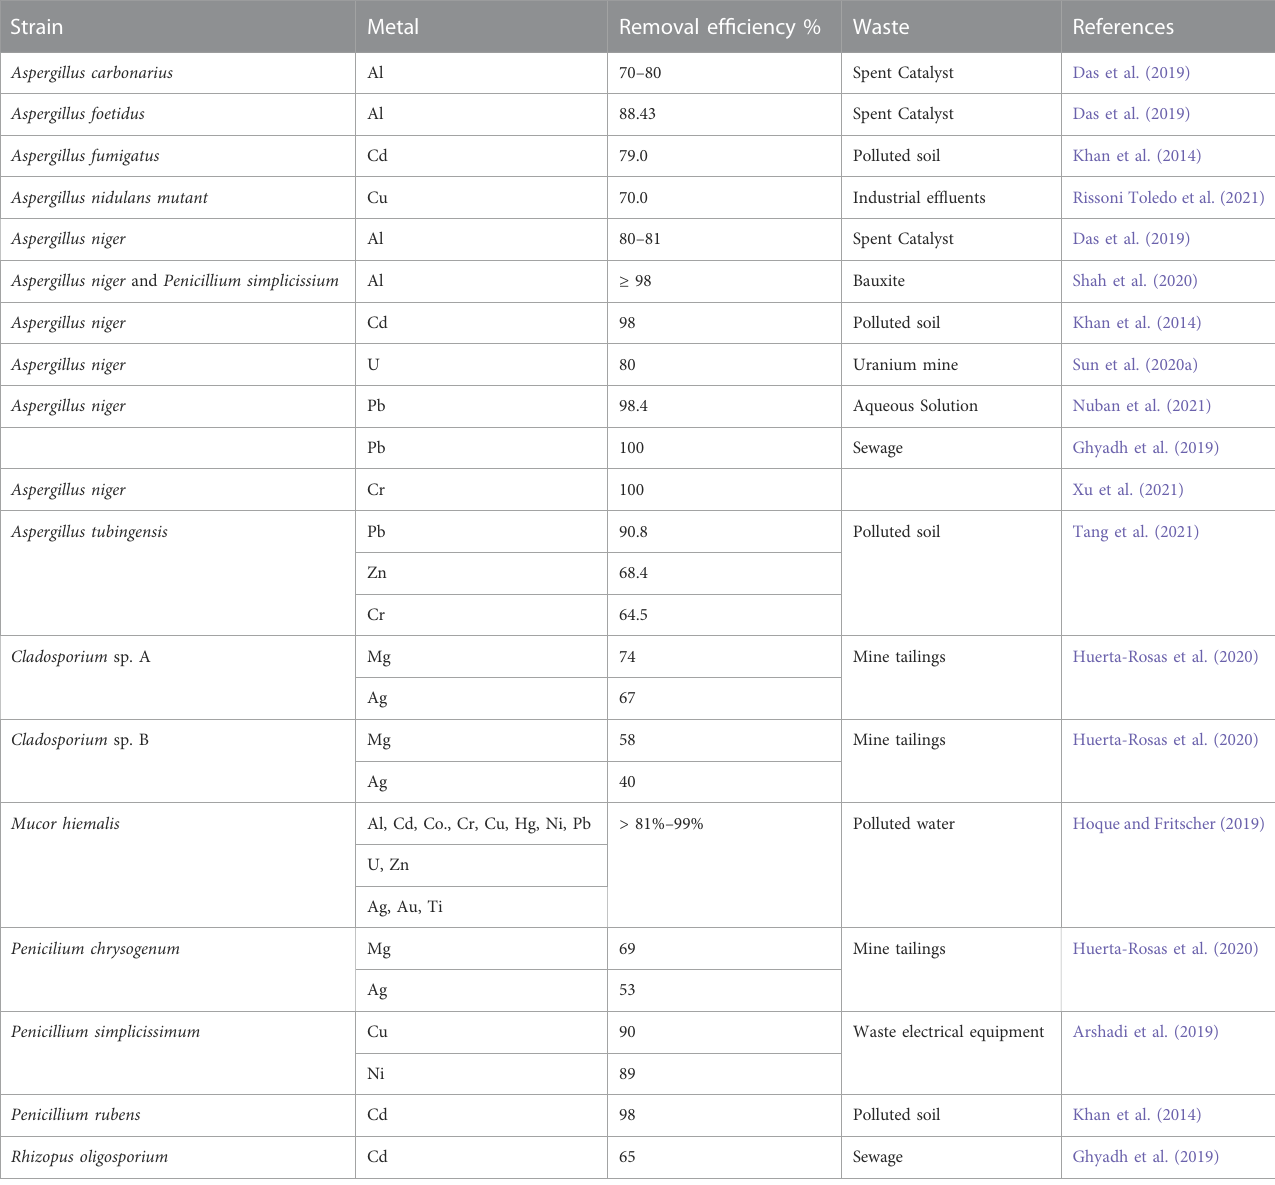
TABLE 3 Heavy metal removal ef fi ciency by fi lamentous fungi reported recently.